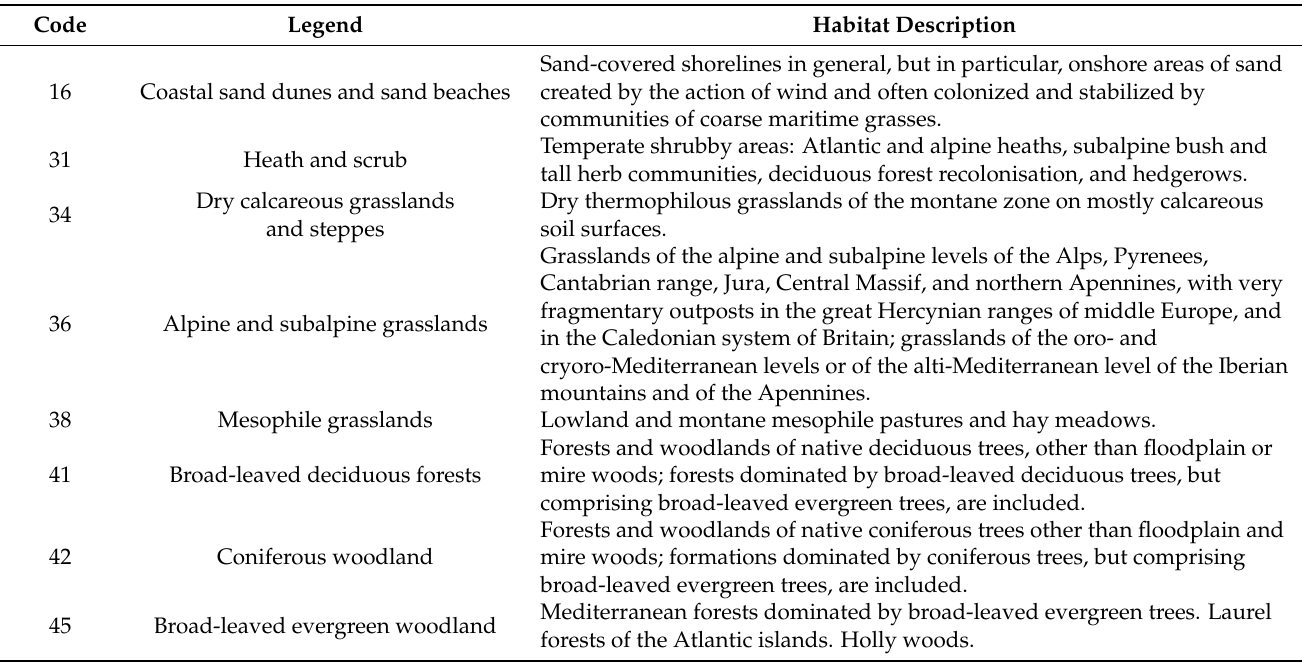
Table 1. Habitat classifications of H. sphondylium according to the data specifications retrieved from the CORINE biotopes manual